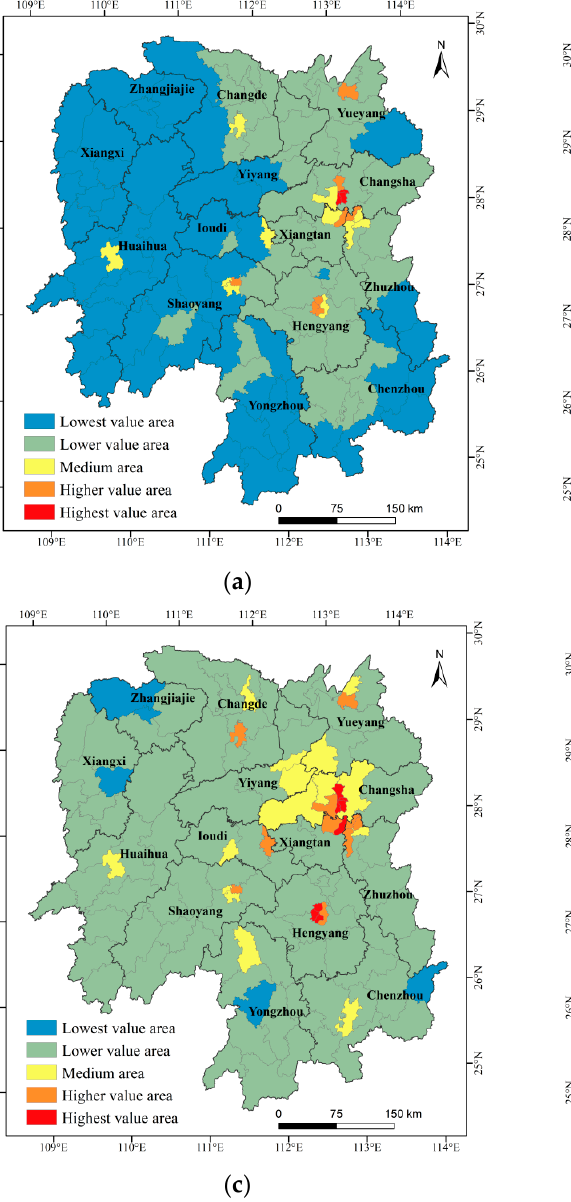
Figure 6. ( a – c ) are the grading maps of the SDG 1 evaluation value of Hunan Province in 2014, 2016 and 2018, respectively, ( d ) SDG 1 evaluation value of Hunan Province’s ellipse distribution.